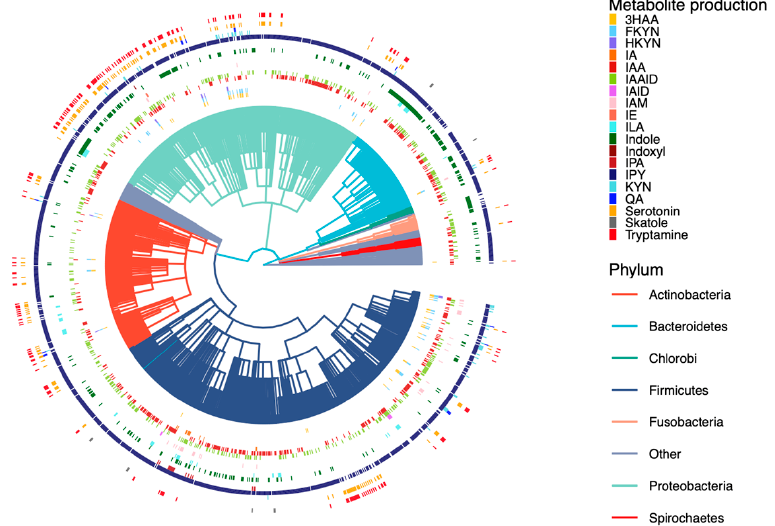
Figure 3. Distribution of tryptophan metabolite production across the human gut microbiome. Each branch indicates a microbe strain colored on the basis of their phyla (3HAA: 3-hydroxyanthranilate; FKYN: formylkynurenine; HKYN: 3-hydroxykynurenine; IA: 3-indoleacrylate; IAA: indole-3-acetate; IAAlD: indole-3-acetaldehyde; Iald: indole-3-carboxaldehyde; IAM: indole-3-acetamide; IE: indole-3-ethanol; ILA: indolelactate; IPA: indolepropionate; IPY: indolepyruvate; KYN: L -kynurenine; QA: quinolinate).